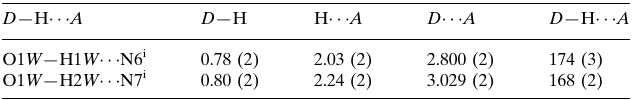
Hydrogen-bond geometry (A˚ , (cid:2)